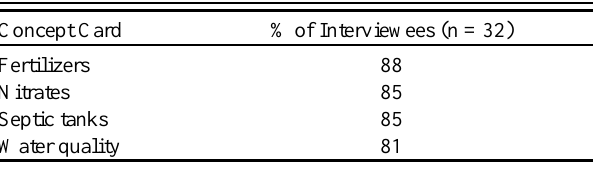
Table 2 . Percentage of interviewees who identified the concept as important to springs